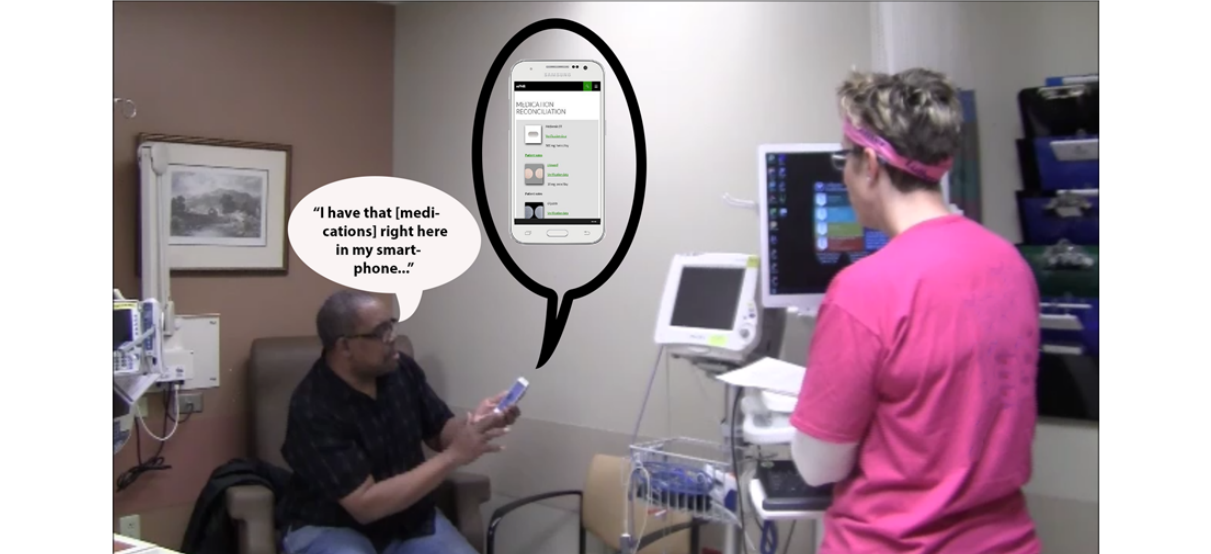
Figure 7. The patient provides accurate medication information by using the prototype to augment his memory, making the attainment of common ground